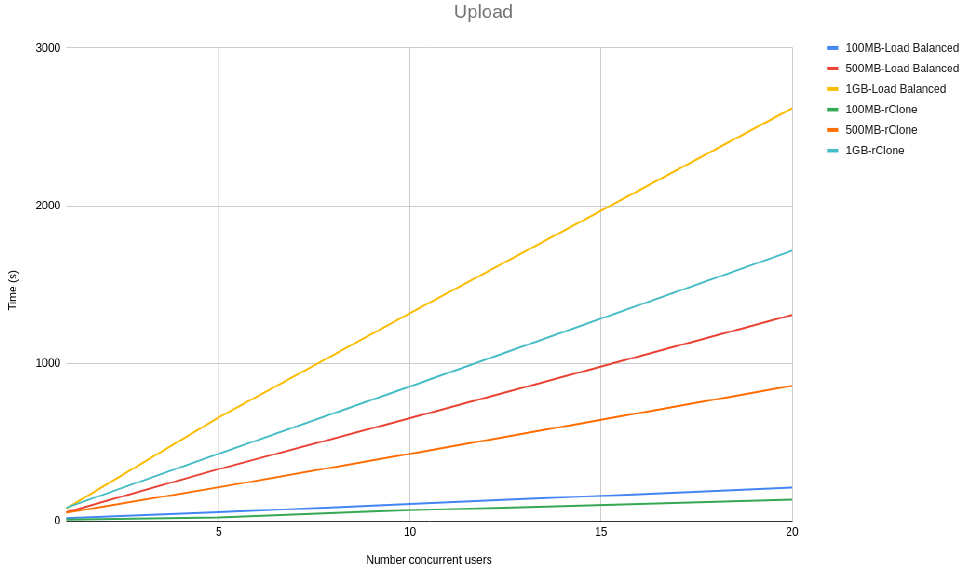
Figure 3. Upload scalability